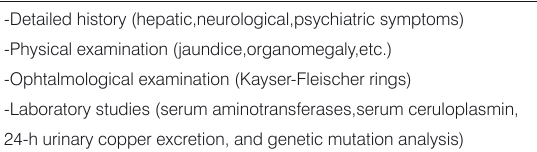
Table 2. Screening for Wilson’s disease.